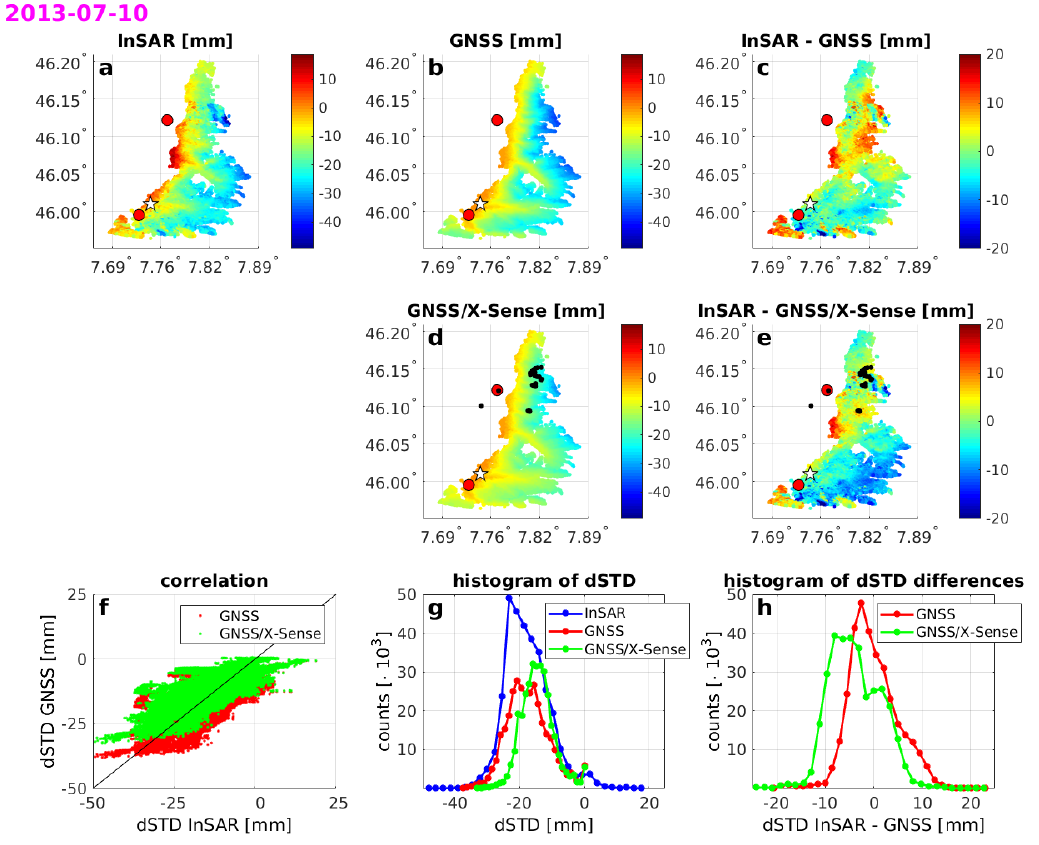
Figure 10. Comparison between InSAR and GNSS-based estimates for 10 July 2013. The plots show ( a ) InSAR-based dSTD s for all PS points; ( b ) GNSS-based dSTD s for all PS points; ( c ) the differences between ( a , b ); ( d ) the combined GNSS/X-Sense estimates; ( e ) the differences between ( a , d ); ( f ) the correlation between InSAR and GNSS or GNSS/X-Sense estimates; ( g ) the histograms of the values and ( h ) the histogram of differences between InSAR and the two GNSS-based models. The white star indicates the reference point, red dots the GNSS stations within the closest research area and black dots the X-Sense